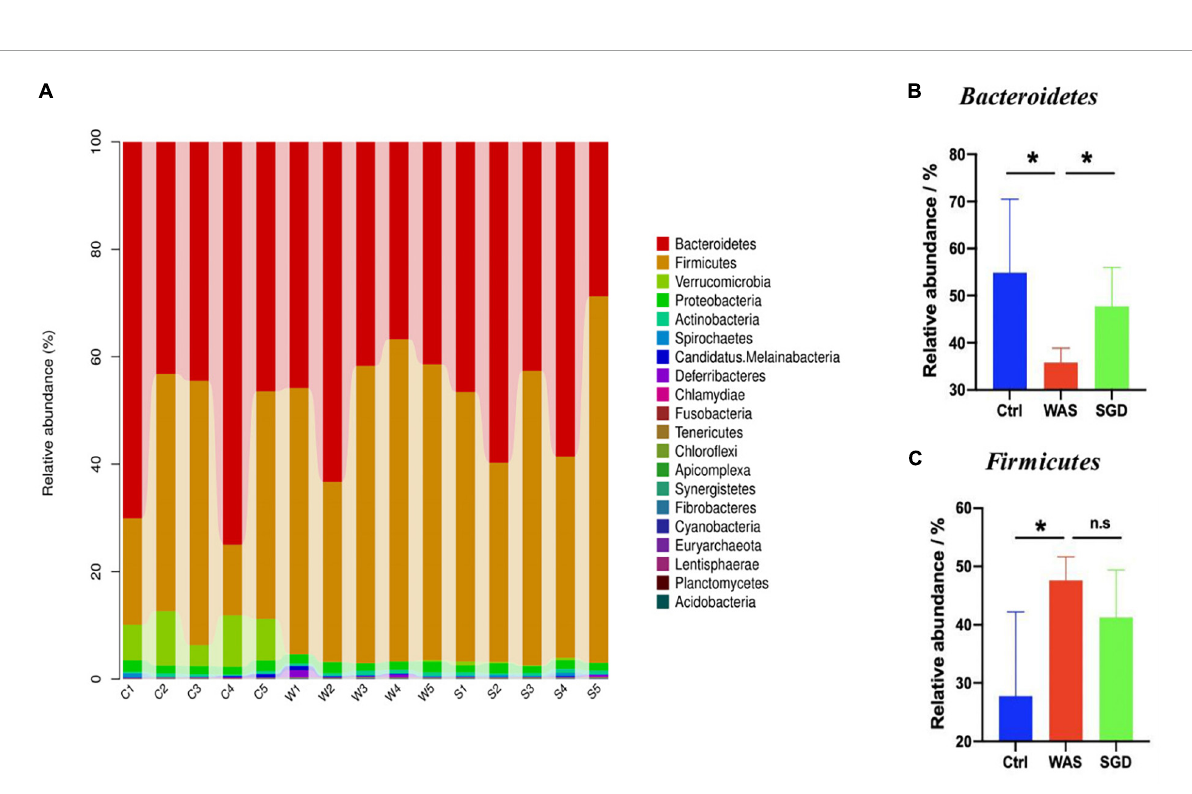
FIGURE3 Effects of SGD on the intestinal microbiota of IBS-D model rats at the phylum level. (A) SGD treatment changed the intestinal microbiota at the phylum level. (B) The relative abundance of Bacteroidetes was decreased in the WAS group compared with the control group; compared with the WAS group, the relative abundance of Bacteroidetes increased in the SGD group. (C) Compared with the control group, the relative abundance of Firmicutes in the WAS group increased; compared with the WAS group, the relative abundance of Firmicutes in the SGD group decreased (* P <